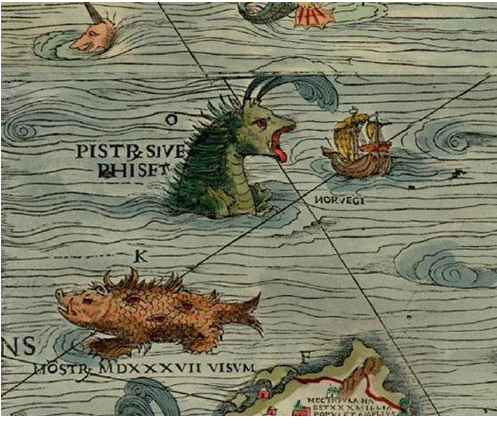
Figure 5. Carta Marina 1539 by Olao Magno (1490–1557), particular.